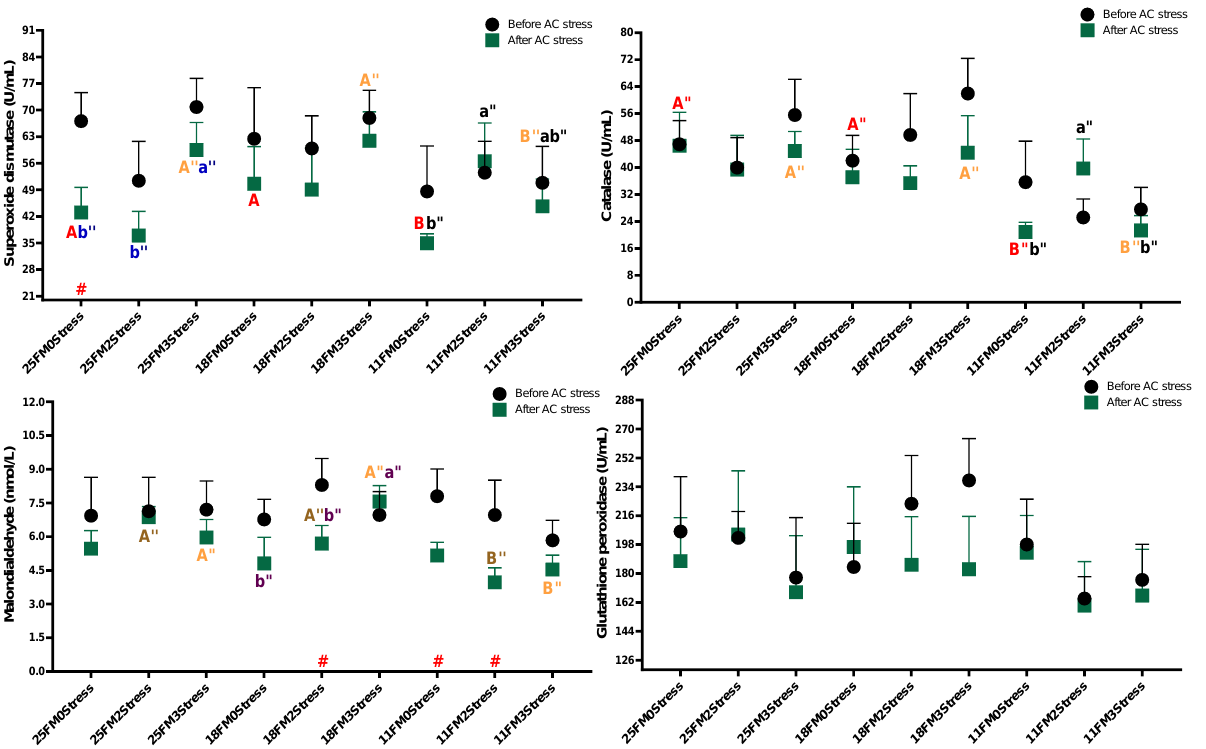
Figure 5. Antioxidant system parameters of oscar fed experimental diets containing different levels of FM and exposed to secluded early mild stress for ten weeks plus data related to after acute confinement stress (AC stress). Values are represented by means and SDM of triplicate samples. Hash (#) with green colour indicates the significant difference in each treatment before and after AC stress according to the independent sample t -test ( p < 0.05). The letters A, B and C with red, brown and orange indicate significant differences among 0Stress, 2stress and 3Stress groups after unpacking the data for the case that interaction was significant. The letters a, b and c in blue, pink and black indicate significant differences among the 25FM, 18FM and 11FM groups. The double quotation marks show that the comparison was among after AC stress groups.